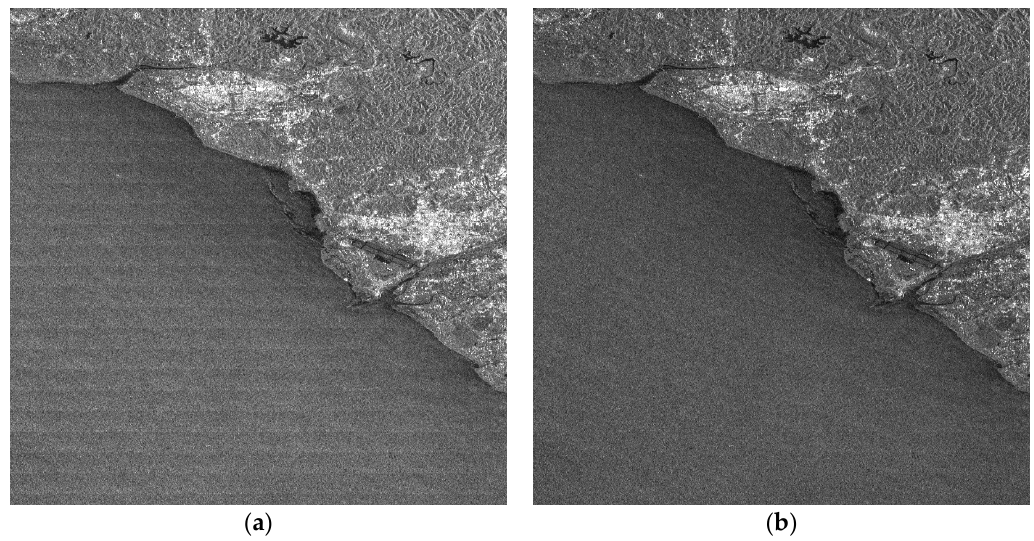
Figure 17. Comparation before and after descalloping of interface between land and sea: ( a ) Frame 2 of Figure 15 before descalloping; ( b ) image after descalloping of ( a ).